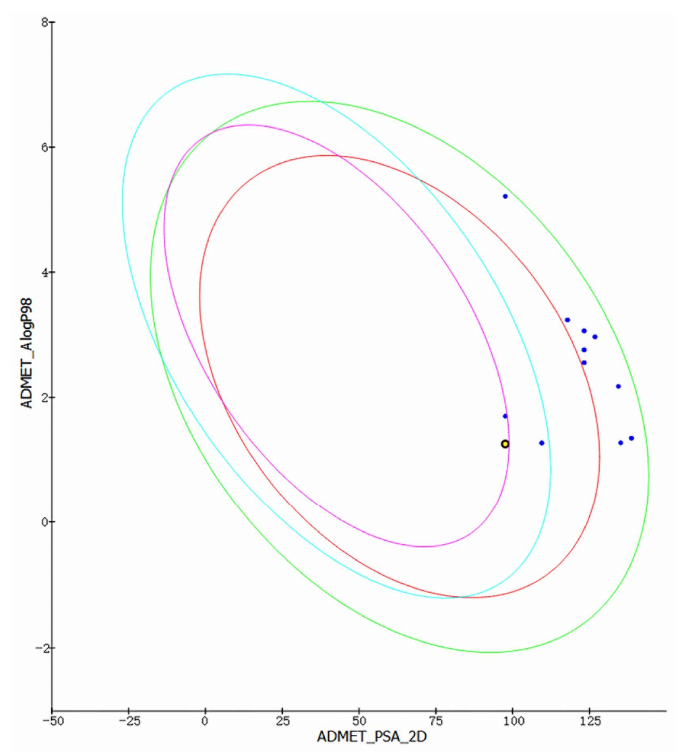
Figure 5. Intestinal absorption model. The purple circle represents 95% of well-absorbed compounds. Table 2. ADME properties of the top twenty compounds in similarity scoring.